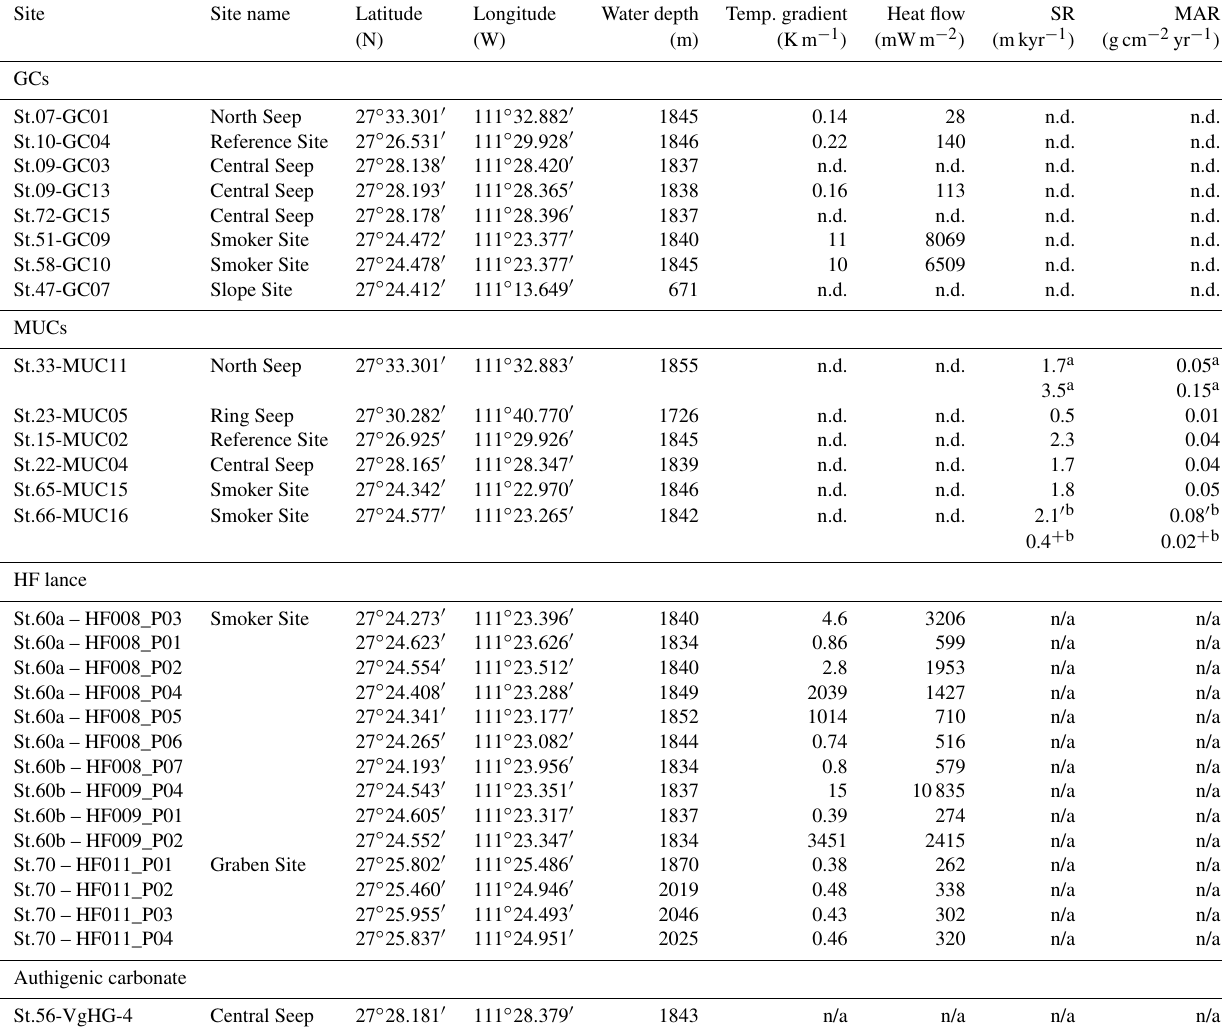
Table 1. Station list and site names of GCs and MUCs taken in the Guaymas Basin with corresponding water depths. Heat flow and temper- ature gradient data measured either attached to GCs or to a sediment